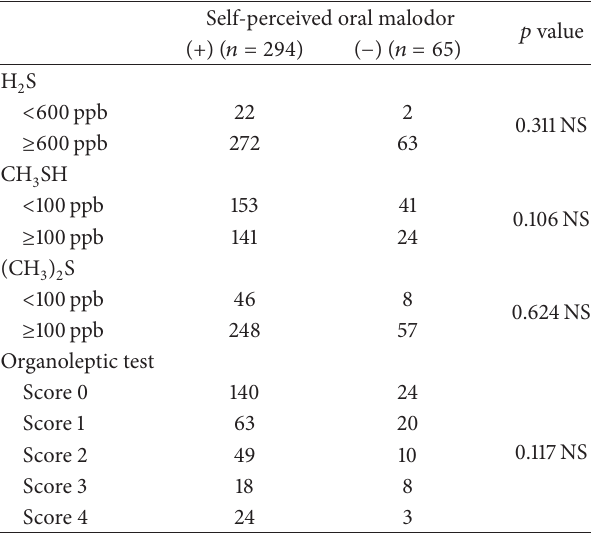
Table 2: Relationships between self-perception of oral malodor and associated